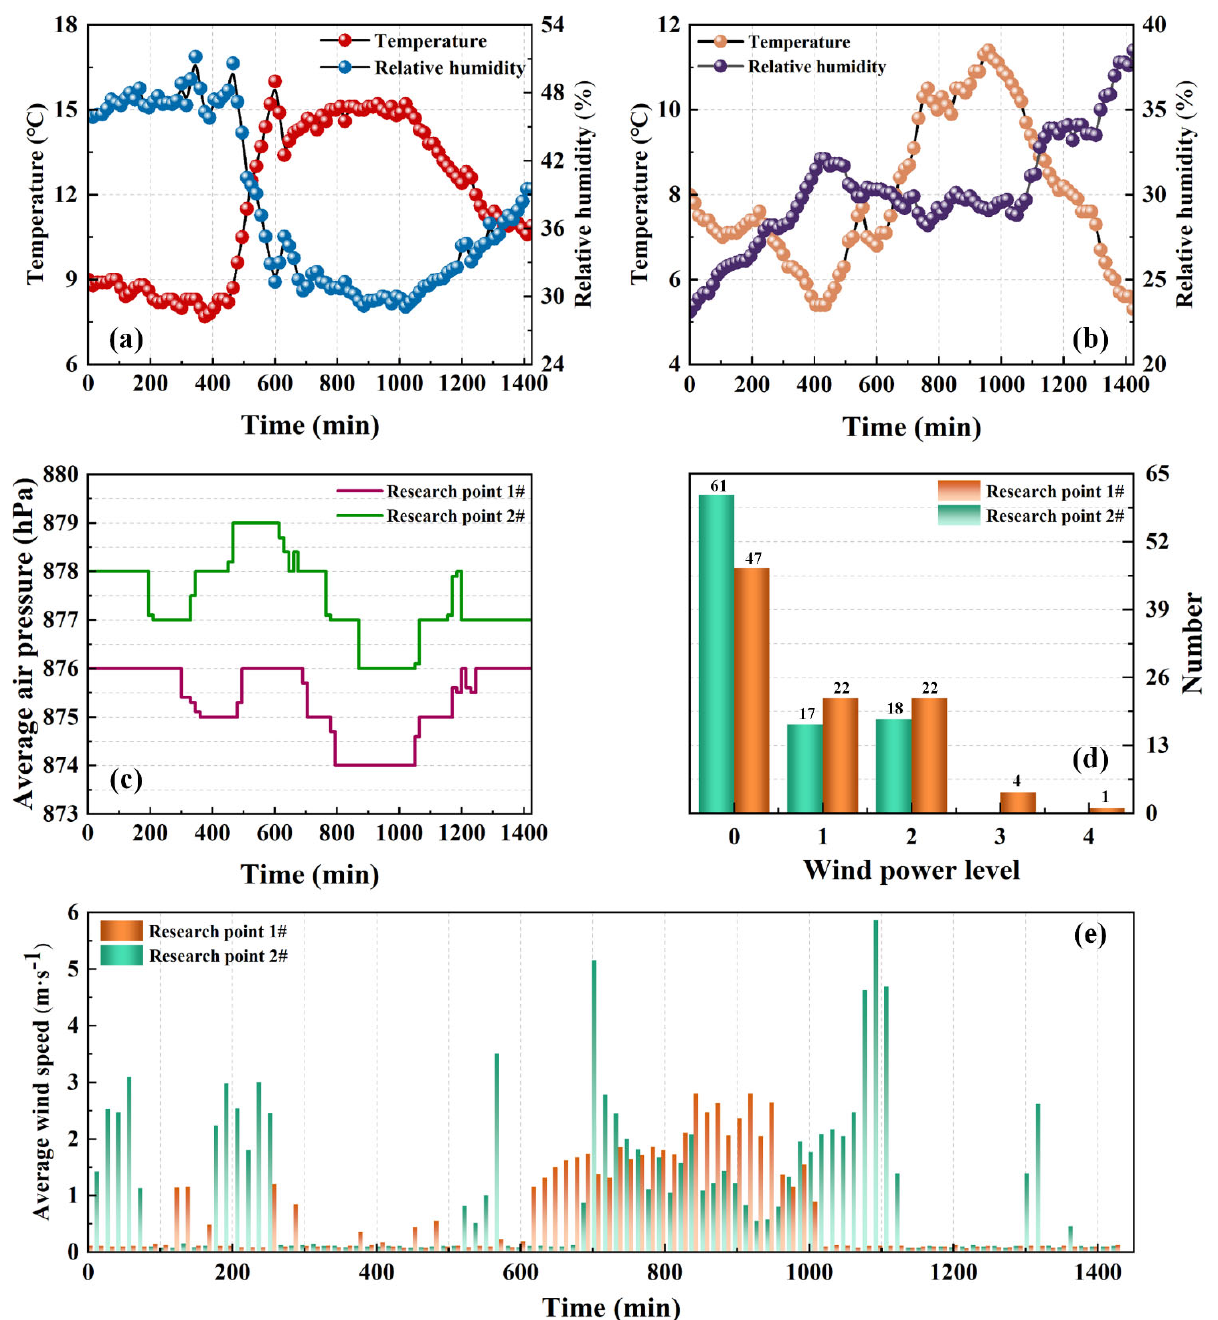
Figure 5. Time variation characteristic map of meteorological factors. ( a ) Temperature and humidity of research point 1#; ( b ) temperature and humidity of research point 2#; ( c ) air pressure; ( d ) wind level; ( e ) wind speed.